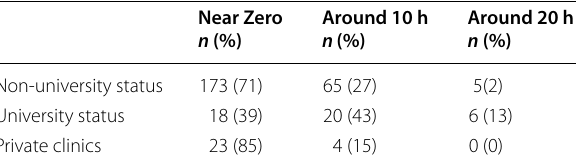
Table 3 Time allocated to research according to university